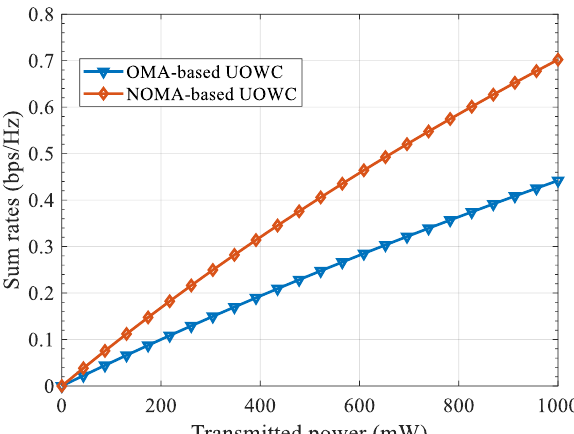
Figure 3. Sum rates versus transmitted power for OMA-based UOWC and NOMA-based UOWC.